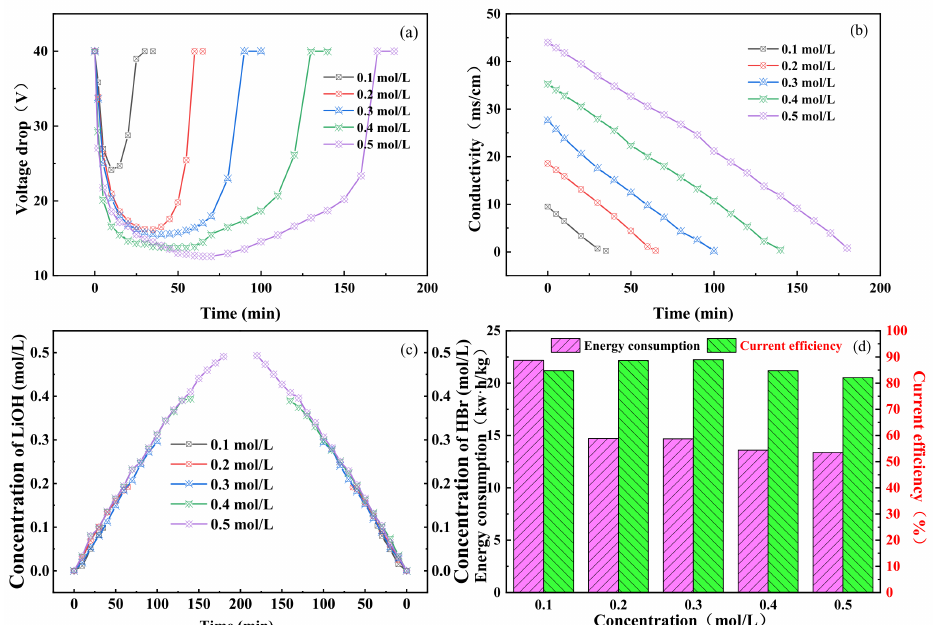
Figure 4. Effect of feed concentration on BMED performance: ( a ) BMED stack voltage drop; ( b ) the conductivity of the salt chamber; ( c ) hydrobromic acid concentration in the acid chamber and lithium hydroxide concentration in the alkali chamber; ( d ) energy consumption and current efficiency of the whole